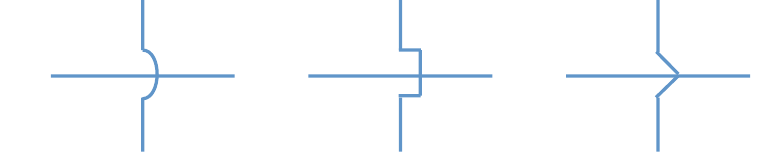
Figure 17: Examples of Interaction crossover patterns.